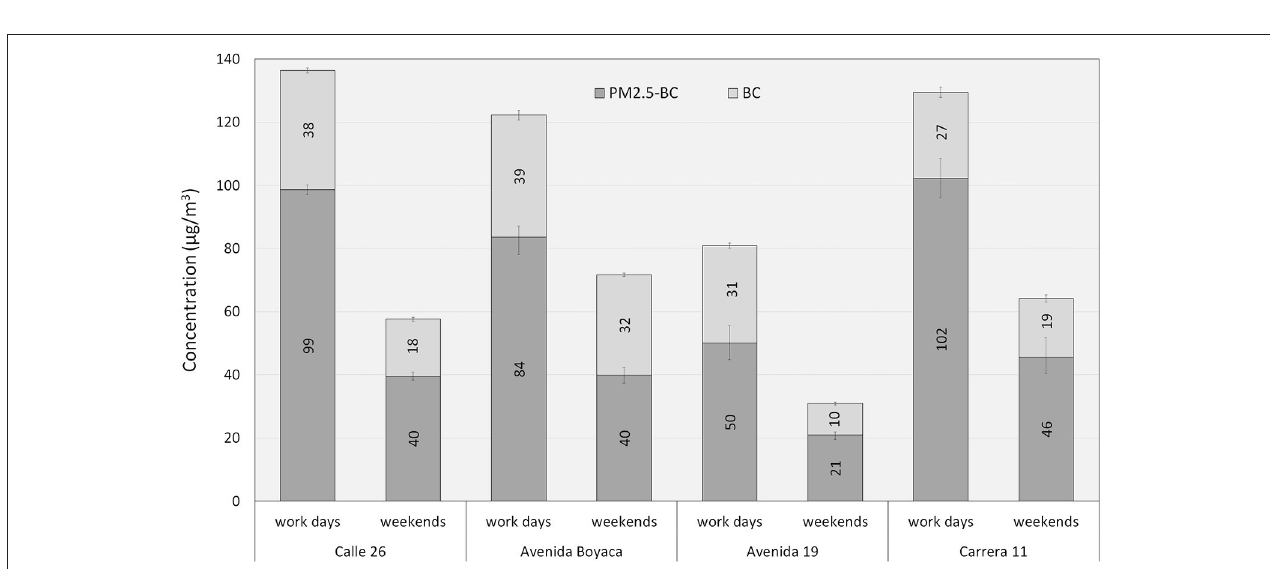
FIGURE 3 | Concentrations of PM 2.5 measured during data collection experiments along the four selected bike-paths.